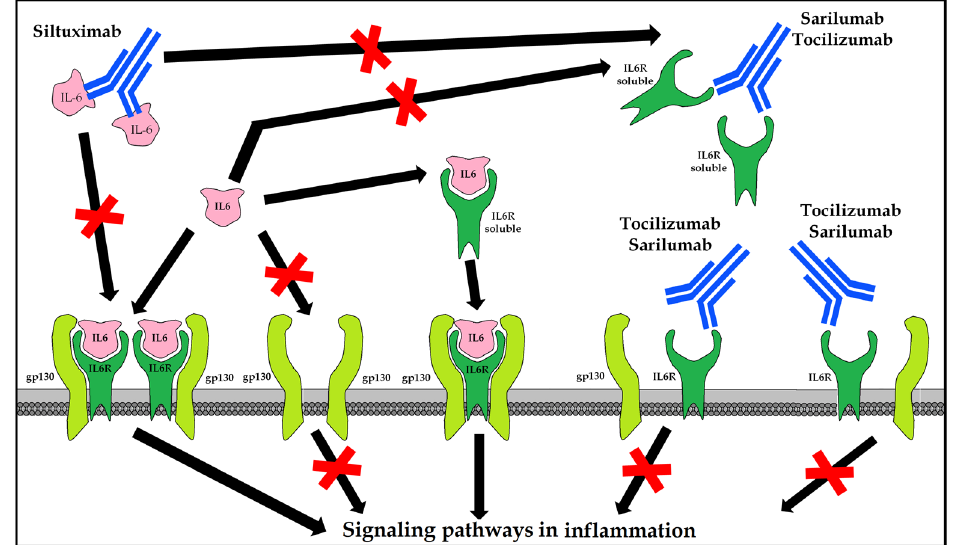
Figure 7. Therapeutic options for blocking the hyperinflammatory response mediated by IL-6.